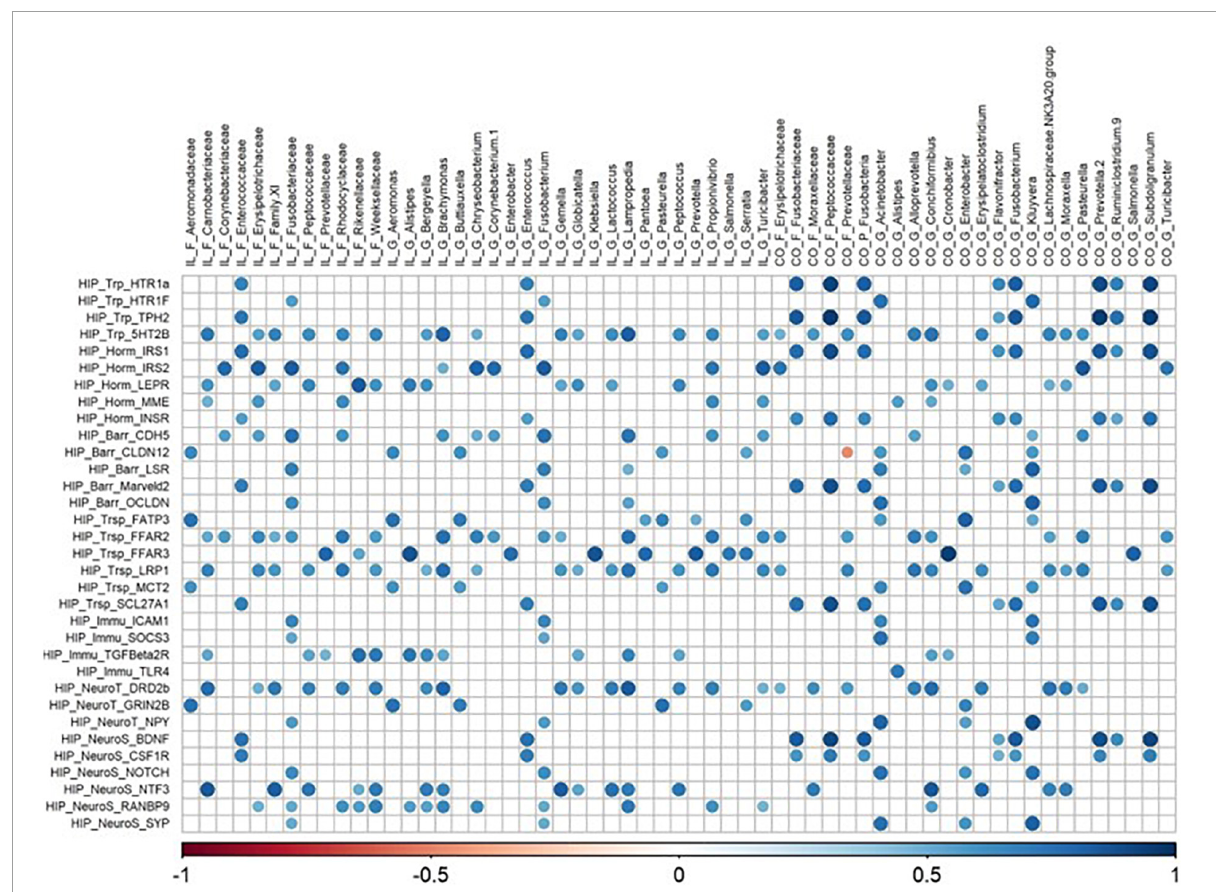
FIGURE7 Correlations matrix between hippocampal relative gene expression and ileal and colonic microbiota (| r | ≥ 0.7, P < 0.05). IL, ileum; CO, colon; F, family; P, phylum; G, genera; HIP, hippocampus; Trp, tryptophan pathways; Horm, endocrine function; Barr, barrier function; Trsp, transport-nutrient carrier; Immu, immune function; NeuroT, neurotransmitters; NeuroS,